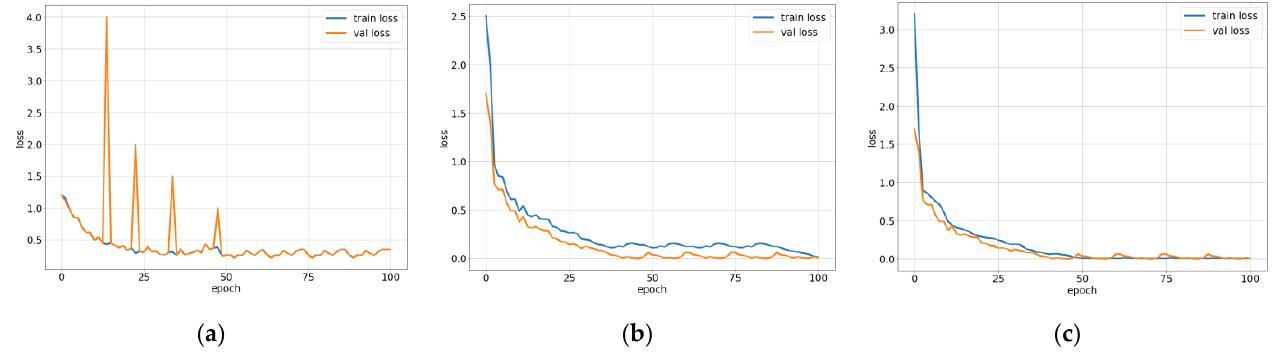
Figure 4. Graph of the loss decline of the model as iterates over the training epochs. ( a ) learning rate is 1 × 10 −3 . ( b ) learning rate is 1 × 10 −4 . ( c ) learning rate is 1 × 10 −5 .